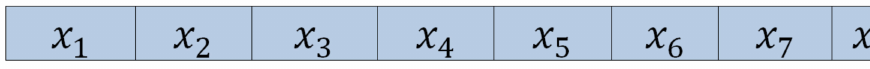
Figure 9. Structure of the particle used in the PSO-CNN-II approach. Table 3. Search spaces used to define the particle in the PSO-CNN-II